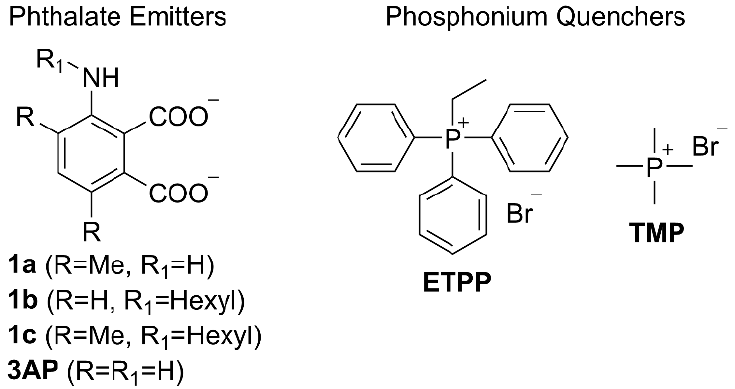
Figure 2. Structures of the phthalate emitters and phosphonium quenchers studied.